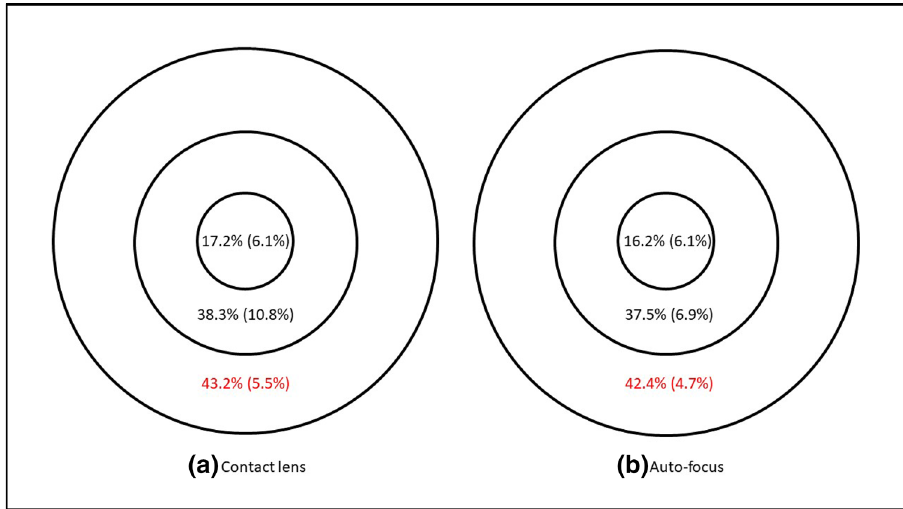
Figure 3. Perfusion density of 74 eyes when corrected with ( a ) contact lens and ( b ) the auto-focus system. Results are expressed as median (interquartile range) using the ETDRS central circle, inner and outer rings of the 6 mm grid. Significant difference between the two correction methods is marked in